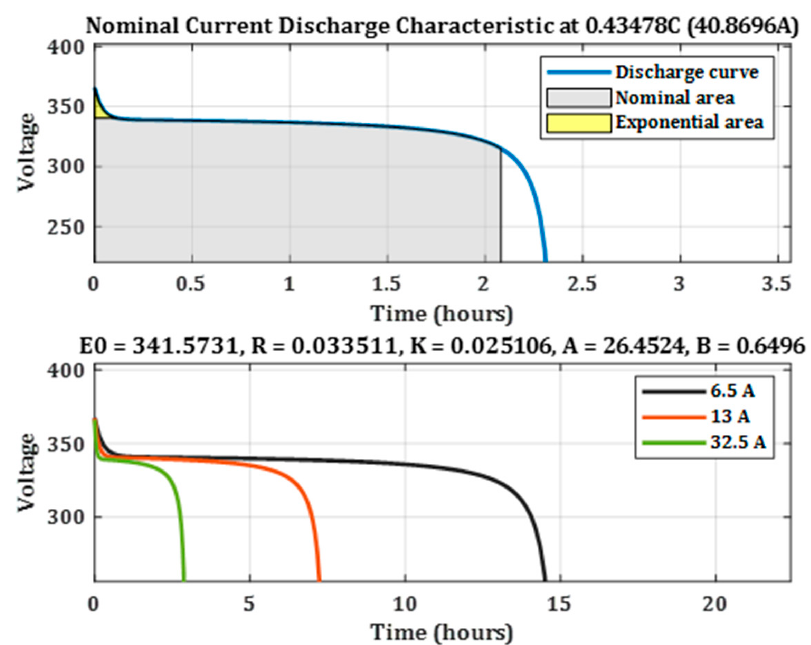
Figure 27. Nominal current discharge characteristics voltage (V) versus time (hrs.).